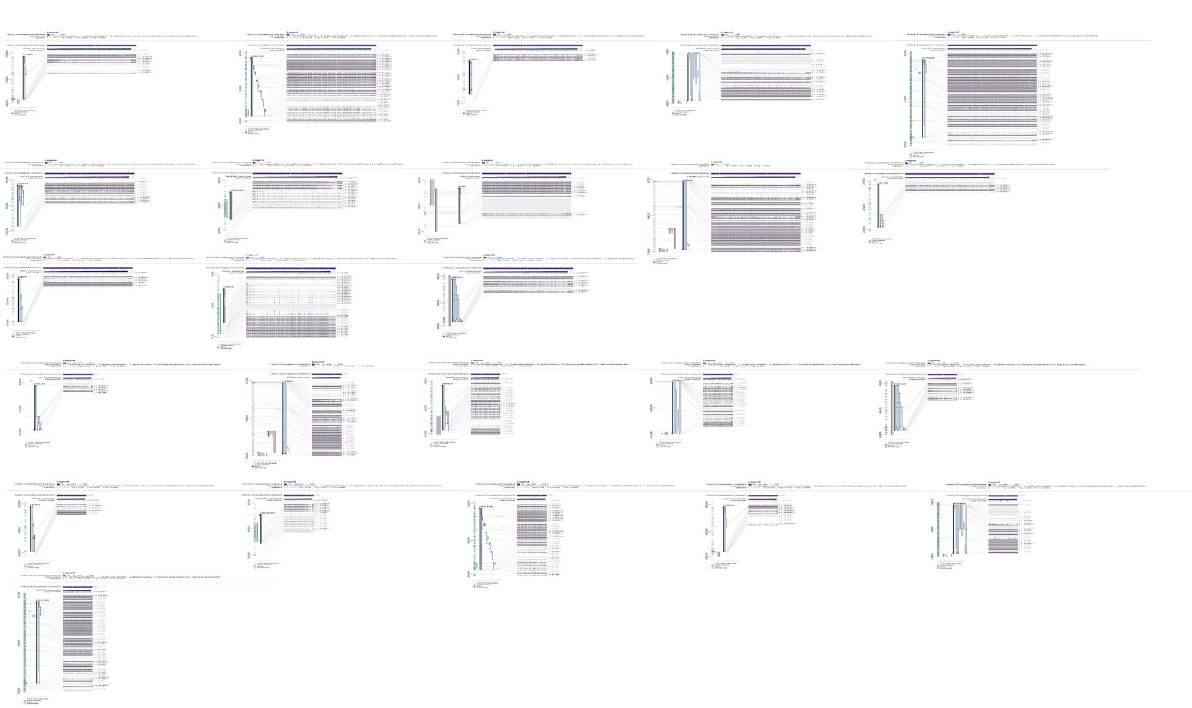
Fig 9. MEXPRESS results of statistically significant over-expressed/hypo-methylated validated Differentially Expressed Genes-Differentially Methylated Genes (vDEGs-DMGs). The first thirteen results pertain to COAD cancer type and the last eleven results correspond to READ cancer type.